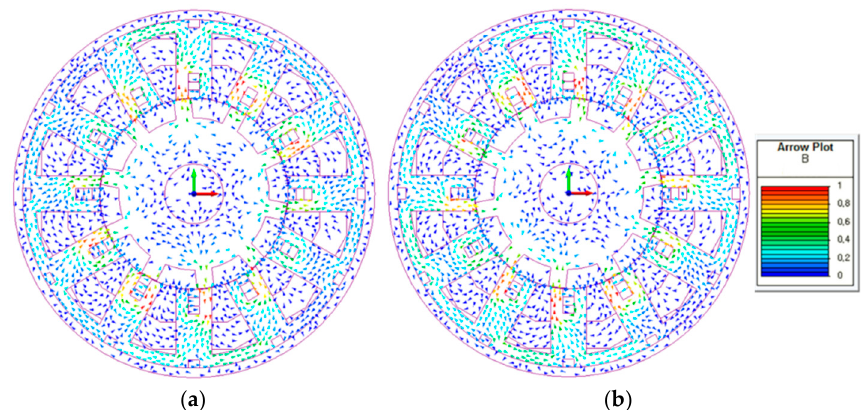
Figure 12. Magnetic flux density vector plots according to the rotor position: ( a ) 0°, and ( b ) 15.75°.